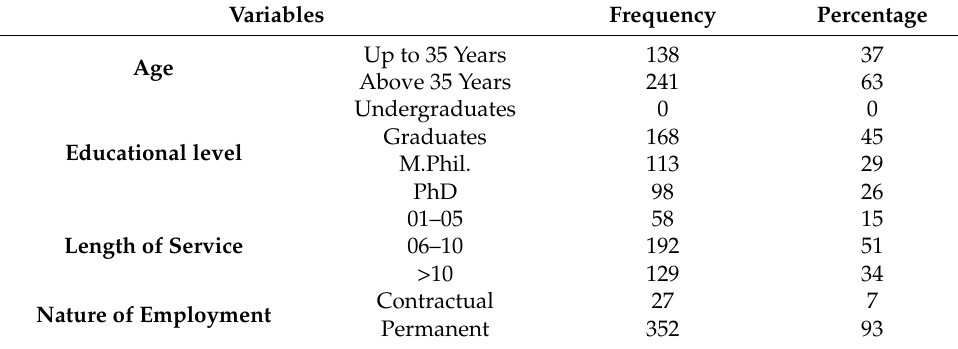
Table 2. Demographic characteristics of the respondents ( n =